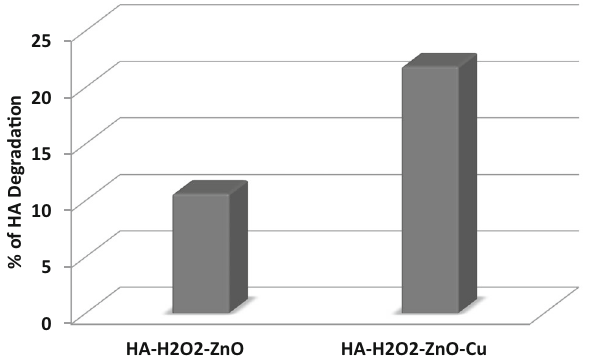
Fig. 5 Percentage of HA degraded by photo-Fenton type reactions under solar irradiation for 3 h